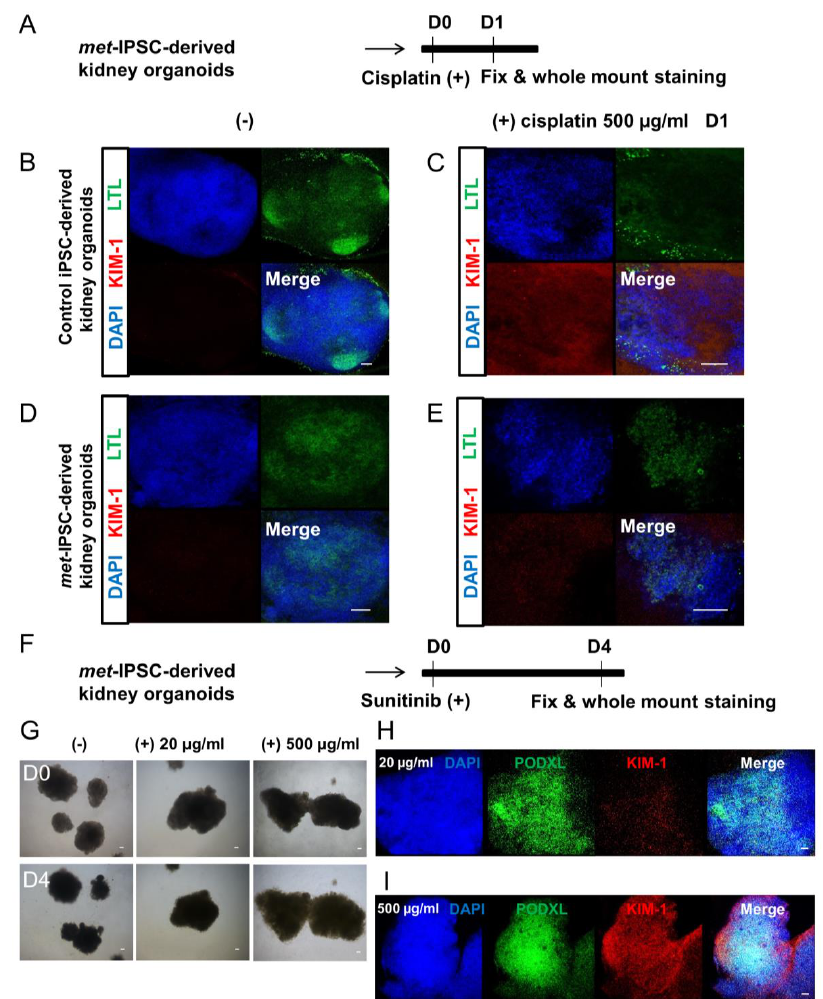
Figure 8. Drug toxicity experiments. ( A ) Schematic representation of cisplatin toxicity experiments in met -IPSC kidney embryoid bodies. ( B – C ) Representative whole-mount immunostaining for LTL, KIM-1 and DAPI in control iPSC-derived kidney embryoid bodies treated with cisplatin (500 µg/mL) (right panels). ( D – E ) Representative whole-mount immunostaining for LTL, KIM-1 and DAPI in met -IPSC-derived kidney embryoid bodies treated with cisplatin (500 µg/mL) (right panels). ( F ) Schematic of drug Sunitinib toxicity test process of met -IPSC-derived kidney embryoid bodies. ( G ) Photograph of met -IPSC-derived kidney embryoid bodies in 96 well plate. ( H ) Representative whole-mount immunostaining for PODXL, KIM-1 and DAPI in met -IPSC-derived kidney embryoid bodies treated with Sunitinib (20 µg/mL). ( I ) Representative whole-mount immunostaining for PODXL, KIM-1 and DAPI in met -IPSC-derived kidney embryoid bodies treated with Sunitinib (500 µg/mL), Scale bar: 100 μm.